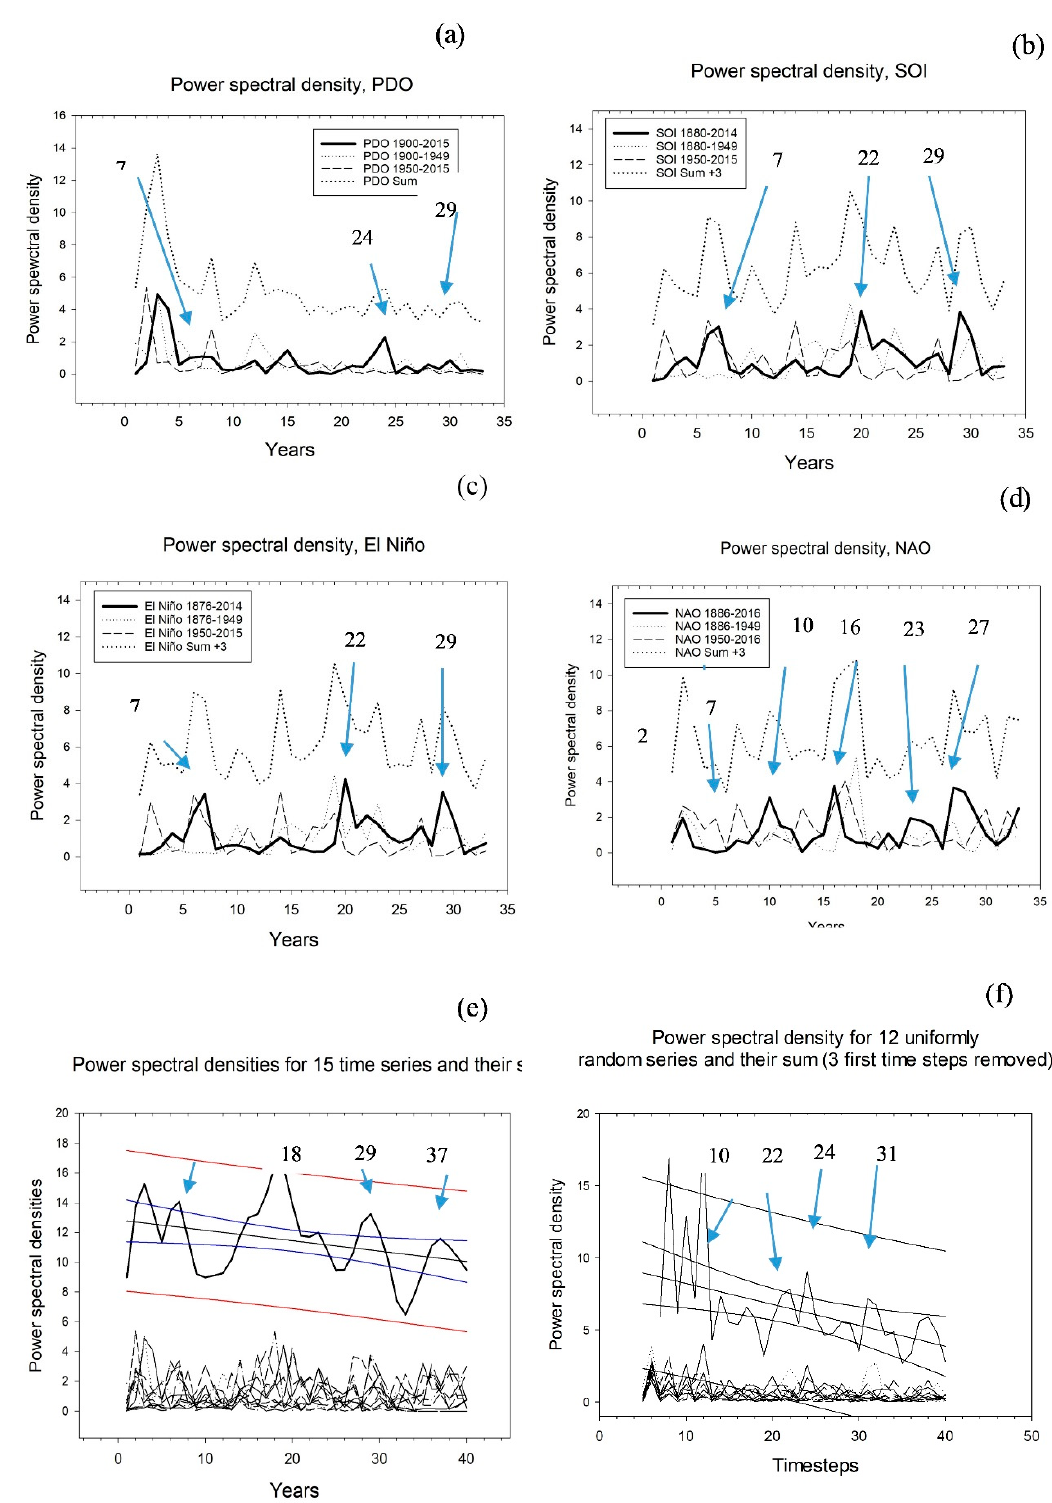
Figure 3. Power spectral density for ocean oscillation time series. The full series and two sub-series divided at 1950; ( a ) PDO; ( b ) SOI; ( c ) El Niño; ( d ) NAO, ( e ) Stacked power spectral densities, (PSD), of 12 observed series. The sum is depicted in bold at the top of the single series with 95% confidence band for prediction of mean and prediction of value, respectively. ( f ) Stacked PSD of 12 uniformly stochastic series. The sum is depicted in bold at the top of the single series with a 95% confidence band.